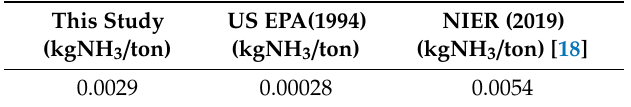
Table 3. NH 3 emission factor of the investigated bituminous coal power plant.